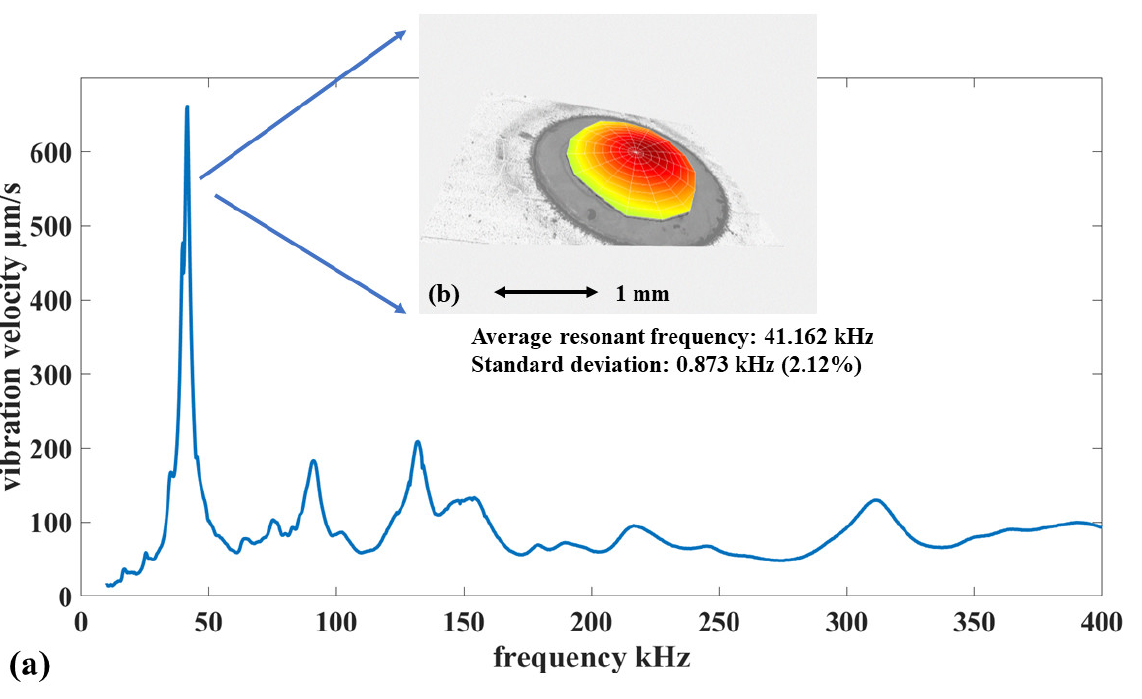
Figure 5. The mechanical resonance measurement result of the MEMS test structures for the mi- crofabrication technology. ( a ) The average spectrum of mechanical resonance for 63 circular membrane MEMS transducers. ( b ) The representative fundamental resonance mode.